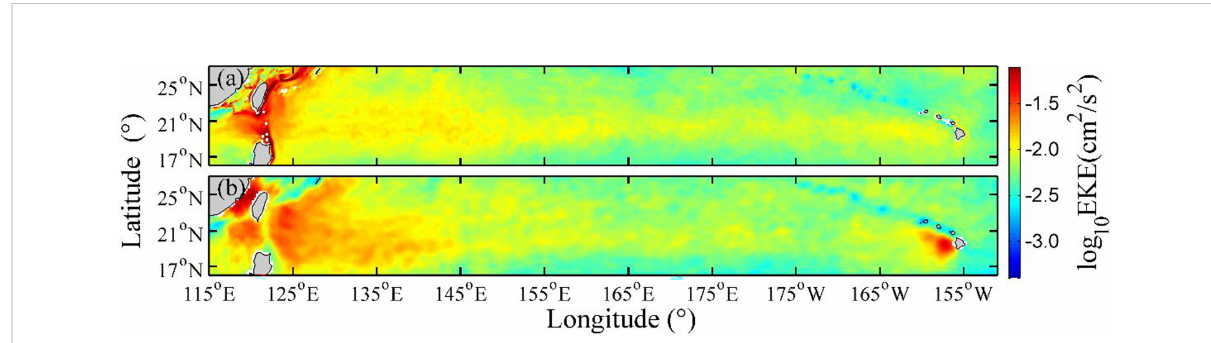
FIGURE 1 Distribution of sea surface eddy kinetic energy calculated from (A) OFES and (B) AVISO data. Shading indicates eddy kinetic energy (units: cm 2 / s 2 ). Note that the eddy kinetic energy is plotted with log base